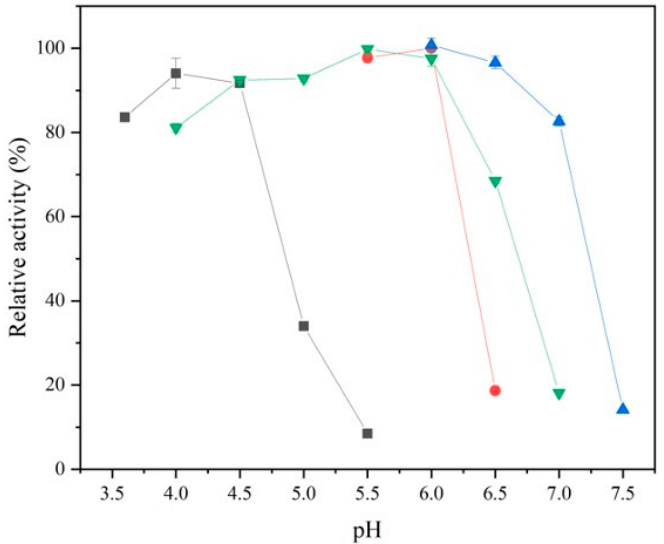
expressed as a ratio of the maximum activity.